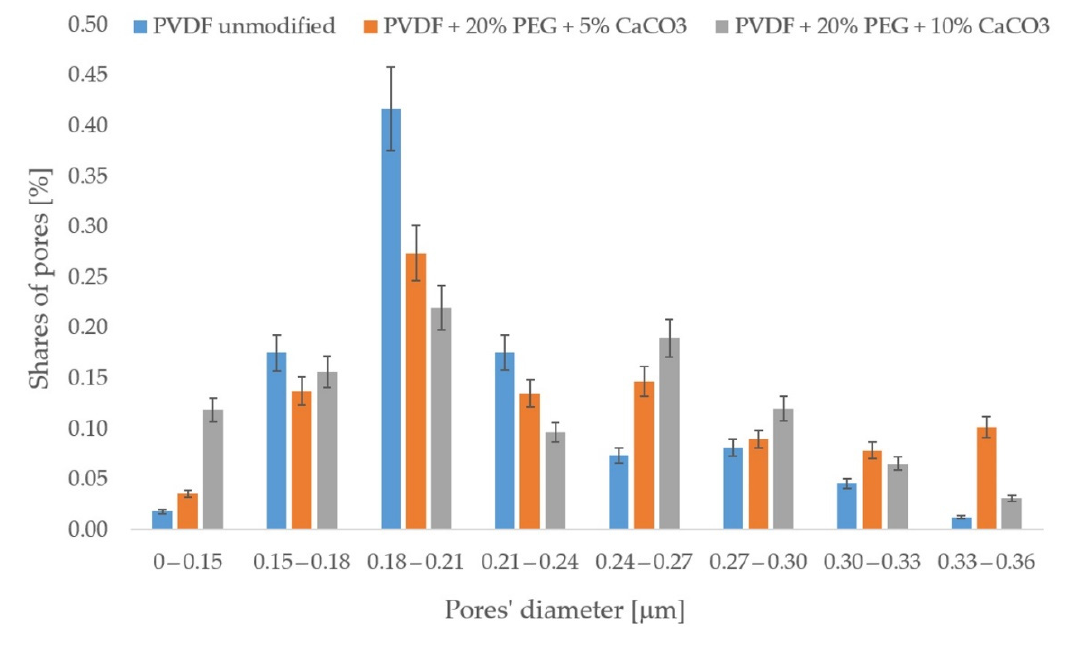
Figure 4 . Results of porosimetry tests. Figure 4. Results of porosimetry